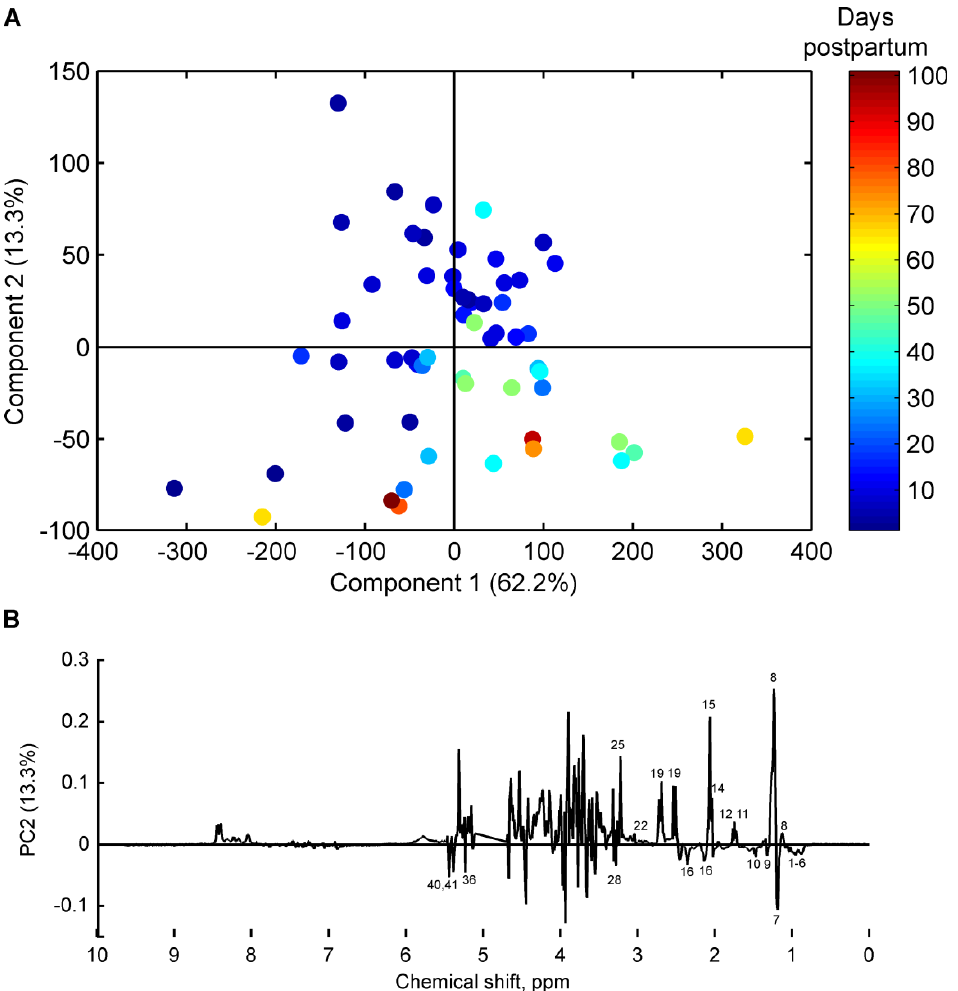
Figure 3. ( A ) Principal component analysis scores plot of pre-term milk samples from 15 mothers ( n = 58), coloured according to number of days postpartum; and ( B ) corresponding loading line plot. For peak assignments refer to Table 3.